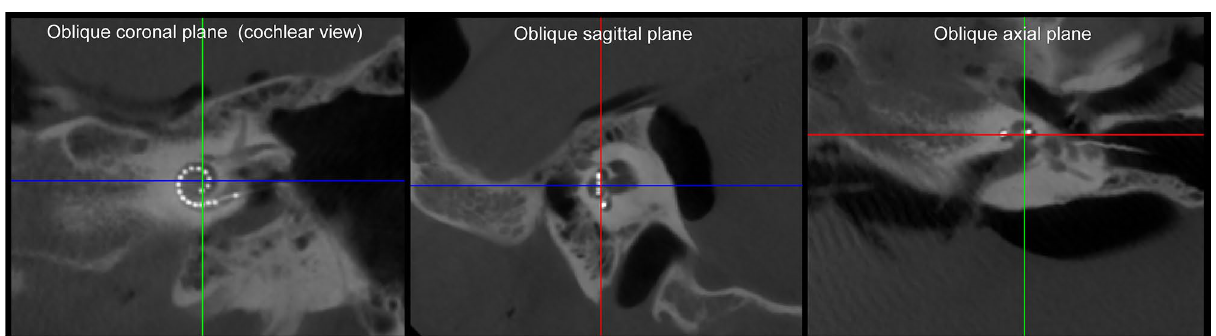
Figure 11. Method for conventional multiplanar reconstructions. The lines in the images represent the position of the shown images relative to the planes. Oblique planes were reconstructed by aligning the red line in sagittal and axial plane to the basal turn of the cochlea, and the blue and green line were aligned to the course of the cochlear modiolus. This resulted in multi reconstructions of three oblique planes: oblique coronal plane, oblique sagittal plane or ‘cochlear view’, and oblique axial